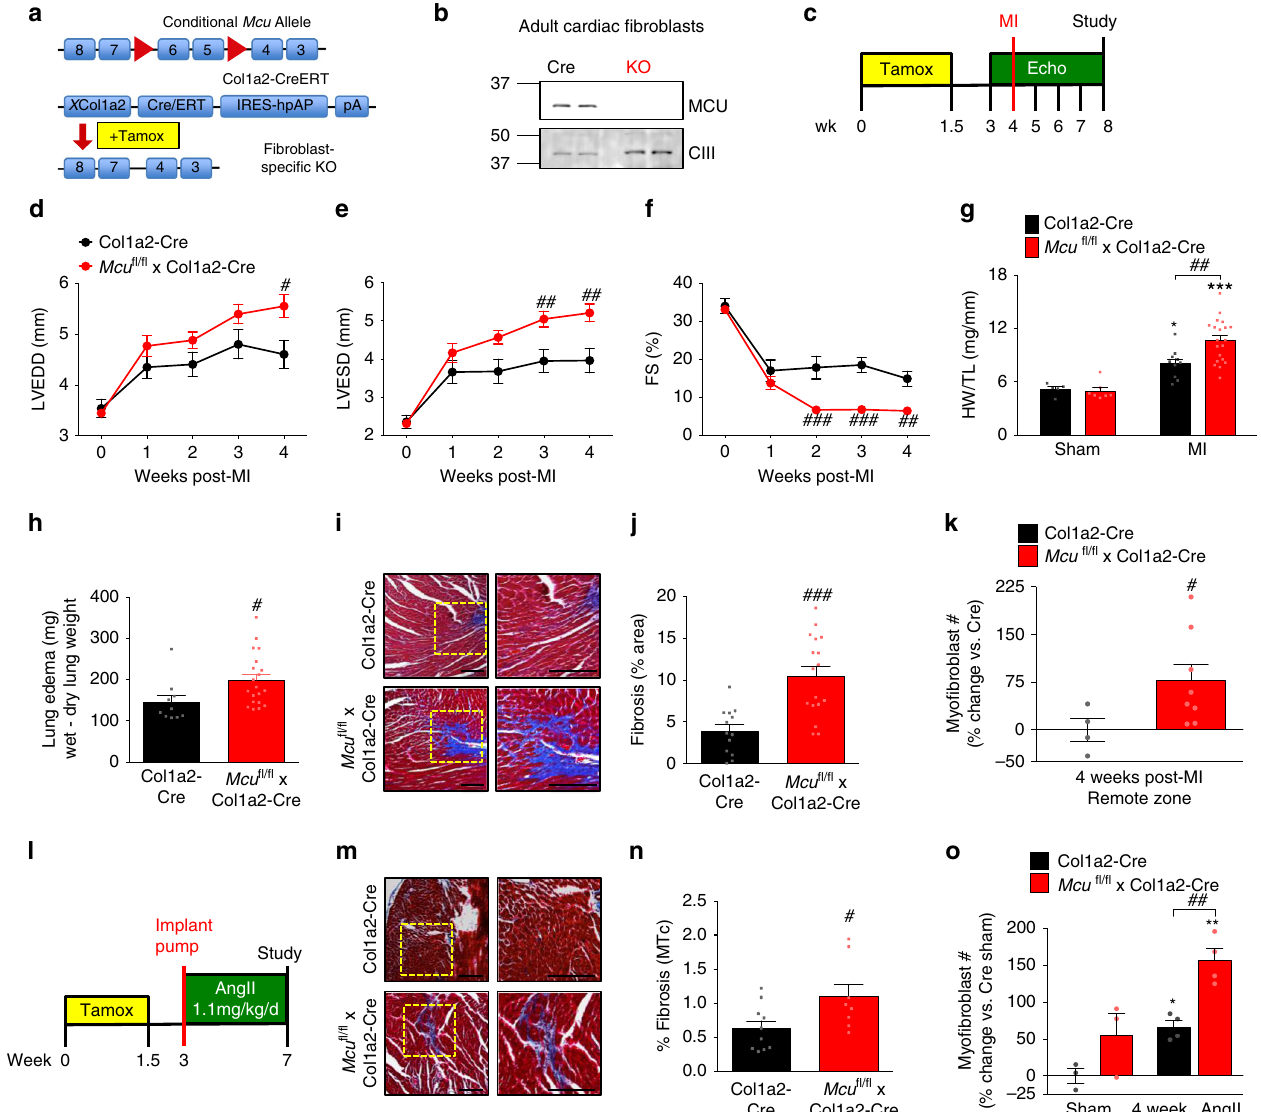
Fig. 6 Adult deletion of fi broblast Mcu exacerbates cardiac dysfunction, fi brosis, and myo fi broblast formation post-MI and chronic angiotensin II administration. a Mcu fl / fl mice were crossed with mice expressing a tamoxifen (tamox)-inducible, fi broblast-speci fi c Cre recombinase (Col1a2-CreERT). Tamox administration (40mg/kg/day) for 10 days induces fi broblast-restricted Cre expression. b Adult cardiac fi broblasts were isolated post-tamox treatment and immunoblotted for MCU expression. CIII (Complex III, subunit-UQCRC2) was used as a loading control. c Experimental timeline: 8 – 12-week- old mice were treated with tamox and allowed to rest before permanent ligation of the left coronary artery. d – f Cardiac function was analyzed by echocardiography 1 week prior to MI and every week thereafter. M-mode echo measurements of left ventricular end diastolic diameter (LVEDD), left ventricular end systolic diameter (LVESD), and percent fractional shortening (FS). n = 10 Col1a2-Cre, n = 20 Mcu fl / fl × Col1a2-Cre. g Ratio of heart weight to tibia length 4 weeks post-MI. Sham: n = 5 Col1a2-Cre, n = 7 Mcu fl / fl × Col1a2-Cre; post-MI: n = 10 Col1a2-Cre, n = 20 Mcu fl / fl × Col1a2-Cre. h Quanti fi cation of wet – dry lung weight as a measurement of lung edema 4 weeks post-MI. n = 10 Col1a2-Cre, n = 20 Mcu fl / fl × Col1a2-Cre. i , j LV sections were stained with Masson ’ s trichrome (MTc). Representative images are shown. Percent fi brotic area per infarct border and remote zones. n = 4 mice per group, multiple non- consecutive heart sections were quanti fi ed per mouse. k Percent change in myo fi broblast number ( α -SMA + /CD31 − ) in the remote zone 4 weeks post-MI. n = 4 Col1a2-Cre, n = 8 Mcu fl / fl × Col1a2-Cre; multiple non-consecutive heart sections in the remote zone were quanti fi ed per mouse. l Experimental timeline: mini-osmotic pumps were subcutaneously implanted in mice to deliver AngII for 4 weeks. m , n Representative images of MTc stained LV sections. Percent fi brosis per area was quanti fi ed. n = 5 Col1a2-Cre, n = 4 Mcu fl / fl × Col1a2-Cre; multiple non-consecutive heart sections were quanti fi ed per mouse. o Percent change in myo fi broblast number ( α -SMA + /CD31 − ) 4 weeks post-AngII infusion. Sham: n = 3; AngII: n = 4; multiple non-consecutive heart sections were quanti fi ed per mouse. All data shown as mean± SEM, *** p <0.001, ** p < 0.01, * p < 0.05 vs. control (week 0 or sham) analyzed by ANOVA. ### p < 0.001, ## p < 0.01, # p < 0.05 vs. Ad- β gal analyzed by t -test. Scale bar = 250 μ m. Also see Supplementary Fig. 7 and Supplementary Table